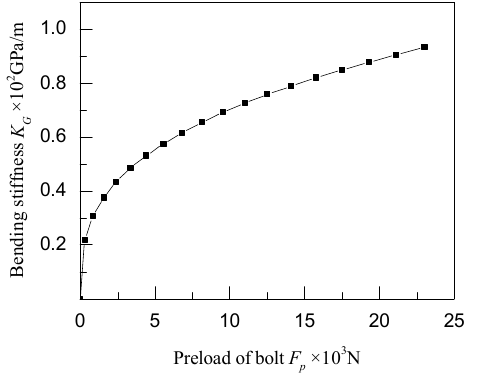
K and preload of bolt F . G p